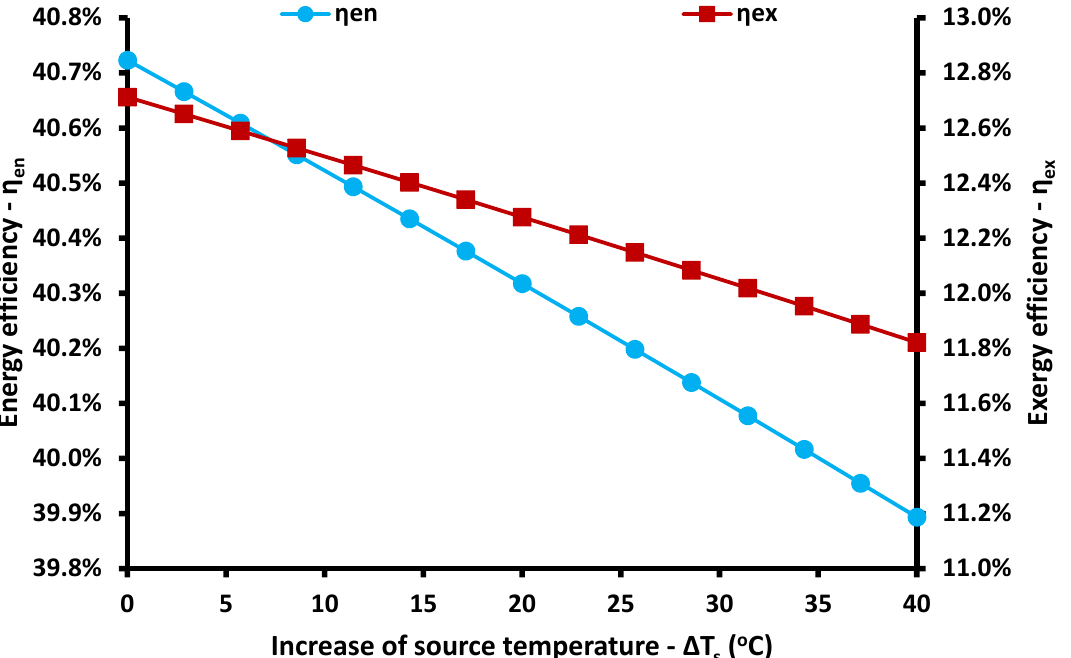
Figure 9. Energy and exergy efficiency for different heating source temperature difference values.